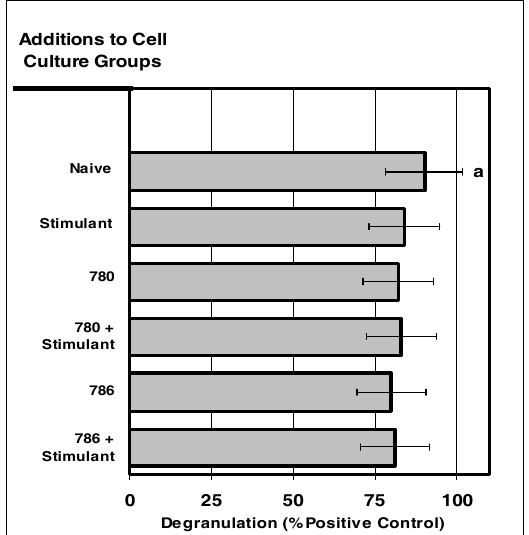
Figure 6: Internalization of NIR micro-sensor dyes did not alter neutrophil degranulation in response to stimuli.